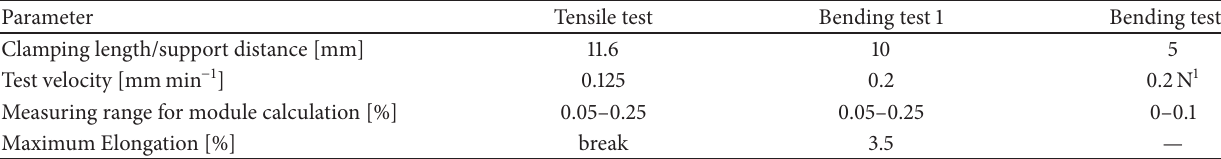
Table 4: Tensile test